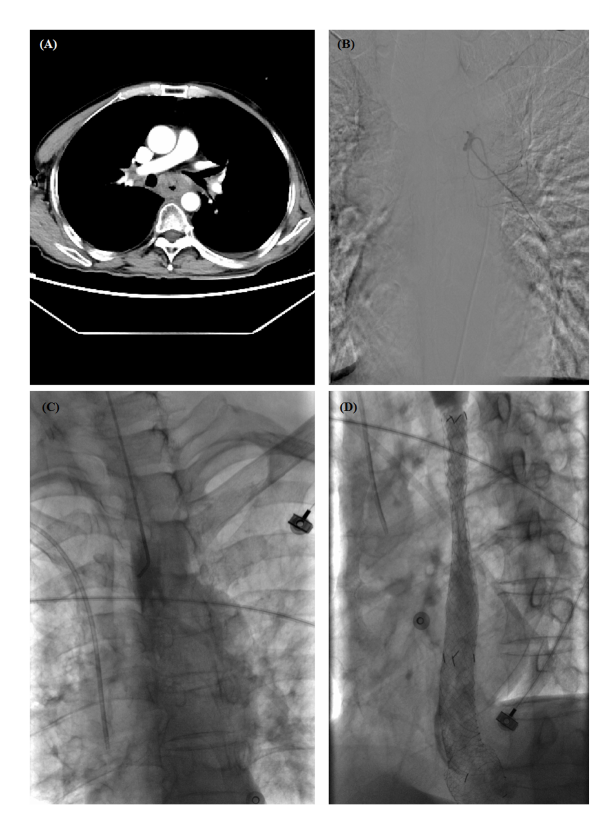
FIGURE 2 A 60-year-old male with esophageal hemorrhage treated by self- expandable metallic stent (SEMS) insertion. (A) Chest computed tomography (CT) scan showed a thickened wall in the middle esophagus. (B) Transarterial embolization was performed, but hemorrhage did not stop. (C) Esophagography showed complete obstruction in the middle esophagus. (D) Esophagography shows a good position and patency of stent after placement. CT, computed tomography; SEMS, self-expandable metallic